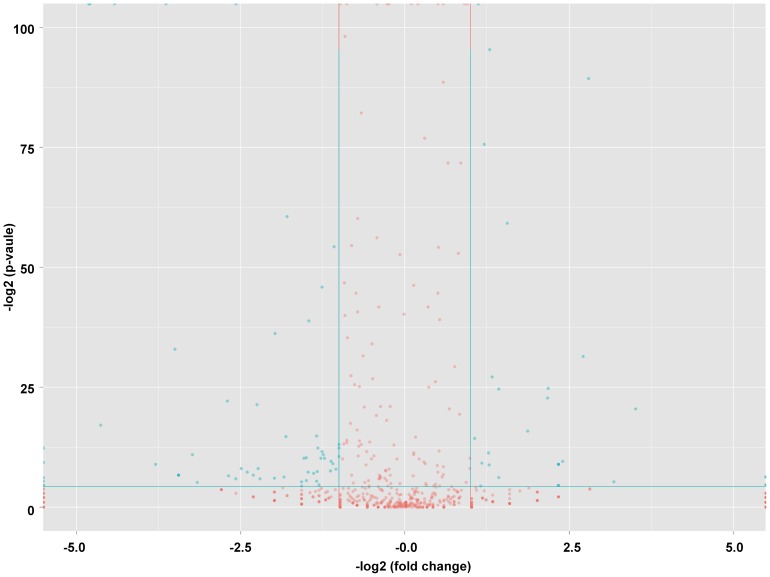
The miRNA expression profiles in CRCs and COCs are presented by volcano plots.The vertical lines correspond to 2-fold up- and down-regulation, respectively, and the horizontal line represents a p-value of 0.05. The red point in the plot represents the similarly expressed miRNAs without statistical significance, while the blue point in the plot represents the differentially expressed miRNAs with statistical significance.